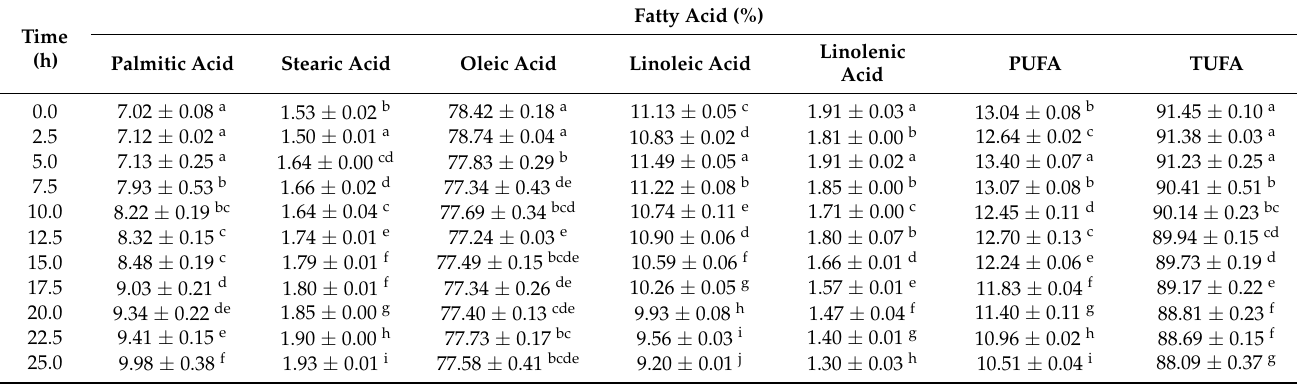
Table 1. Change in fatty acid composition during frying.